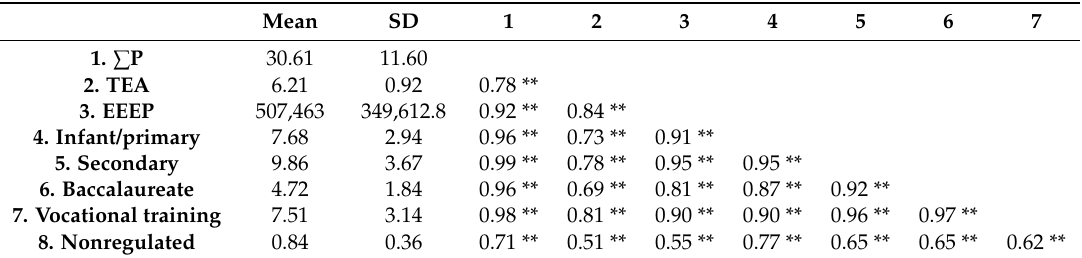
Table 4. Descriptive statistics and correlations.